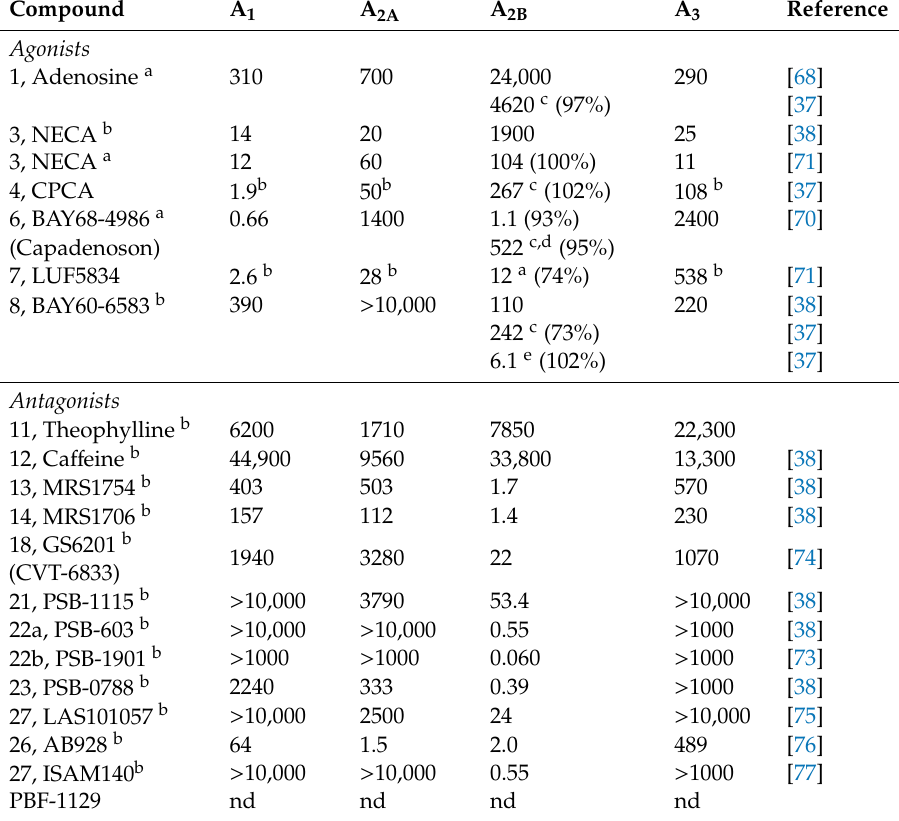
Table 1. Binding a ffi nity (K i , nM) or functional potency (EC 50 , nM; E max as %) of commercially available A 2B AR agonists and antagonists as pharmacological tools and A 2B AR antagonists in clinical trials for cancer patients. Refer to Figure 2 for structures. K i (nM) or EC 50 (E max ,